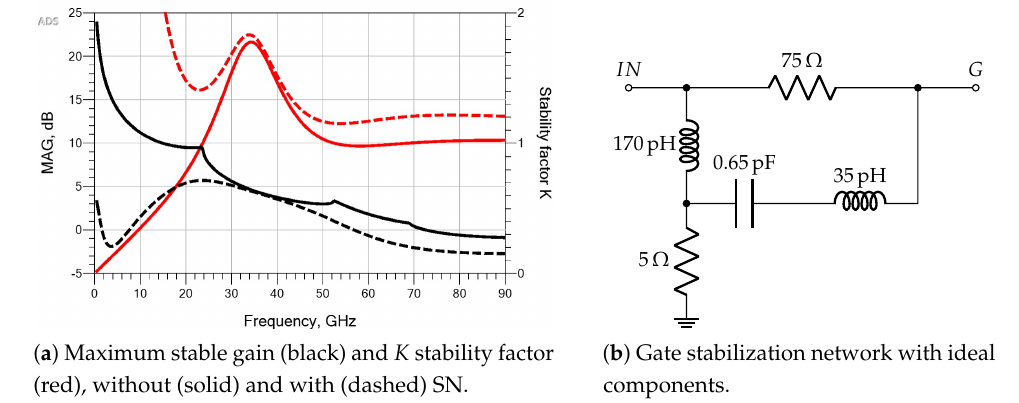
Figure 5. Small-signal stability analysis of the 8 × 75 µ m device at T BS = 80 ◦ C and at the selected bias